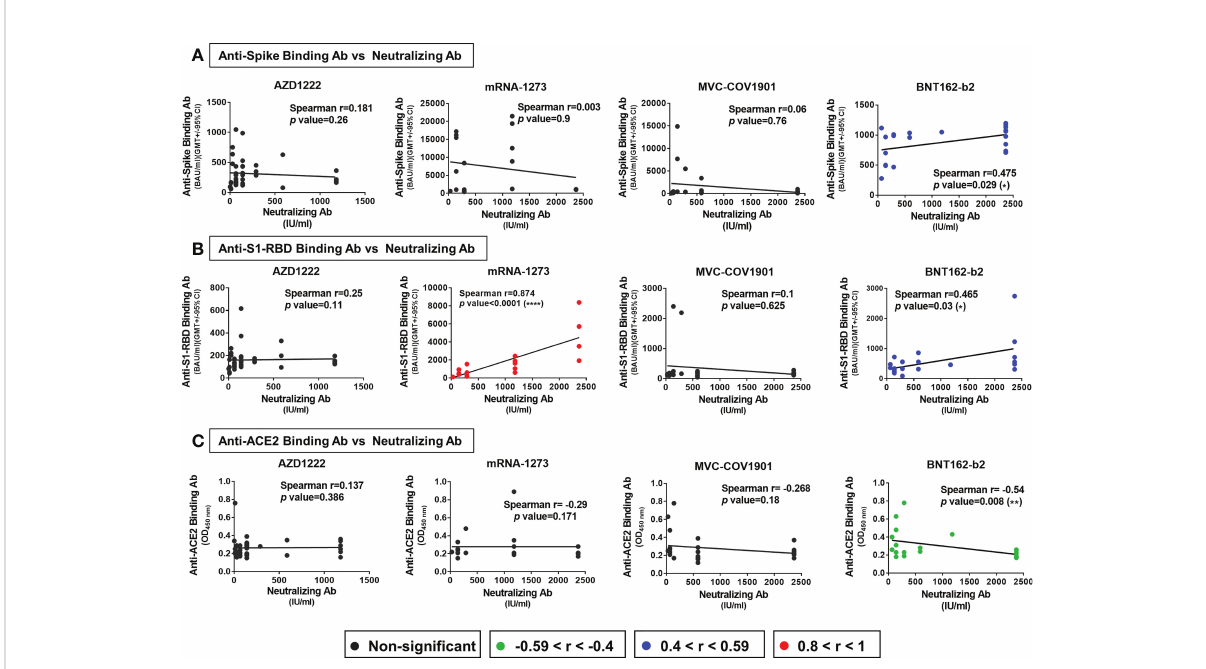
FIGURE 3 Factors correlated with neutralizing titers in different vaccine groups. The correlation of (A) anti-spike binding antibody levels (B) anti-S1-RBD antibody levels (C) anti-ACE2 antibody levels and neutralizing antibodies titers (NT50) of the AZD1222, mRNA-1273, MVC-COV1901, and BNT162-b2 vaccinees ’ sera were evaluated. The levels of correlation coef fi cients are presented with different colors and the statistical signi fi cance in the correlations between each factor and neutralizing titers was shown. *P<0.05, **P<0.01, ****P<0.0001.